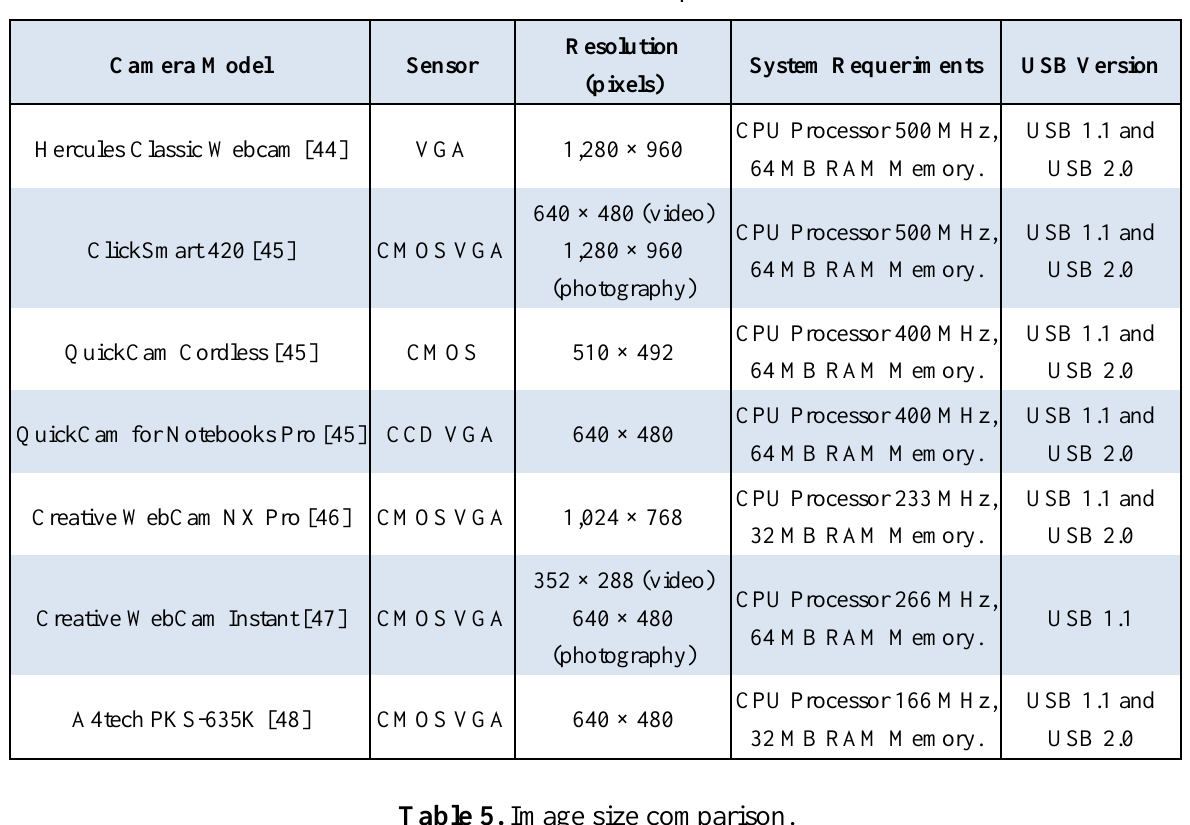
Table 4. Camera comparison.